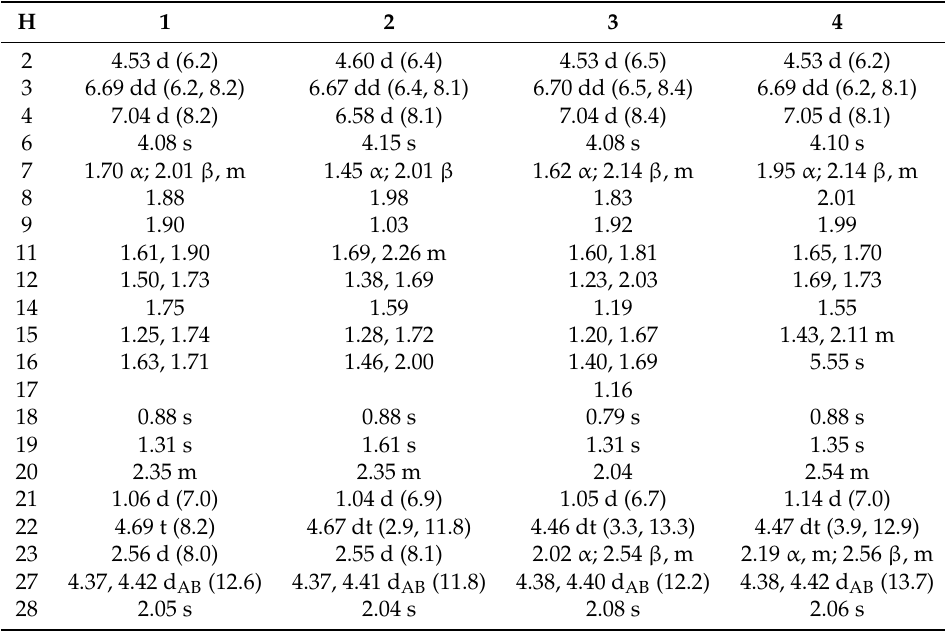
Table 1. 1 H-NMR spectroscopic data for compounds 1 – 4 a